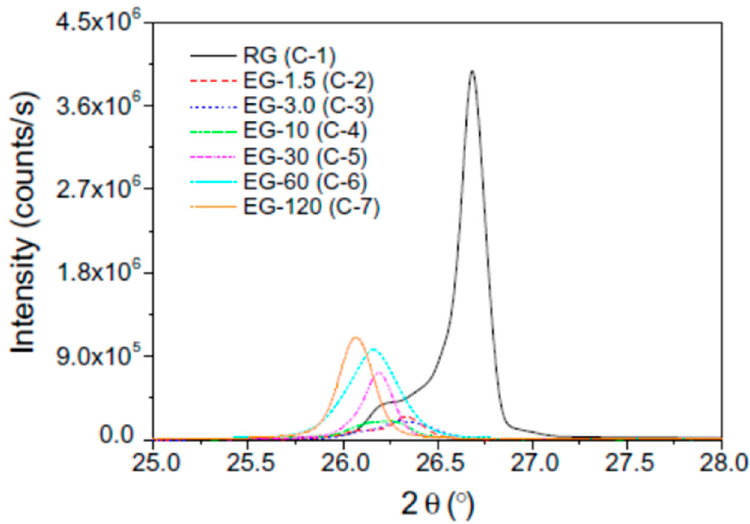
Figure 5. X-ray diffraction patterns of the RG (C-1) and EGs as a function of the heat treatment time (C-2 to C-7).